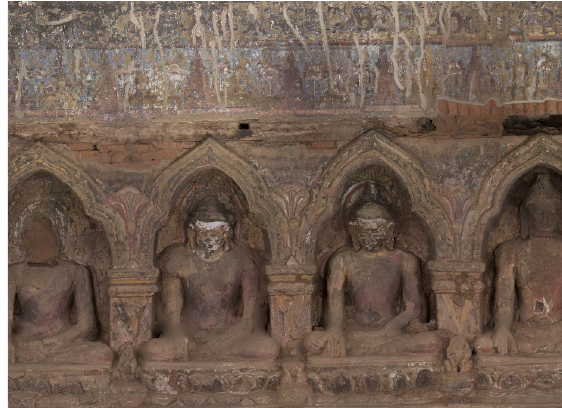
Figure 7. The 2020 orthophoto of the East inner wall in Myin- pya-gu, showing the same section as Figure 5. The image is mostly in focus and evenly lit but still has shadows cast in the niches (Credit: Carleton Immersive Media Studio; Carleton University. © J. Paul Getty